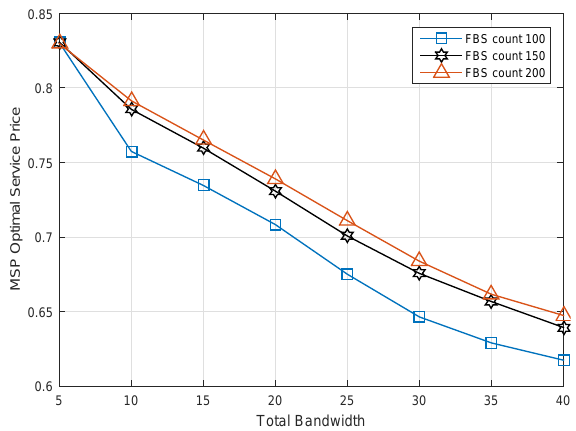
Figure 7. Optimal service price versus total bandwidth under different FBS counts.